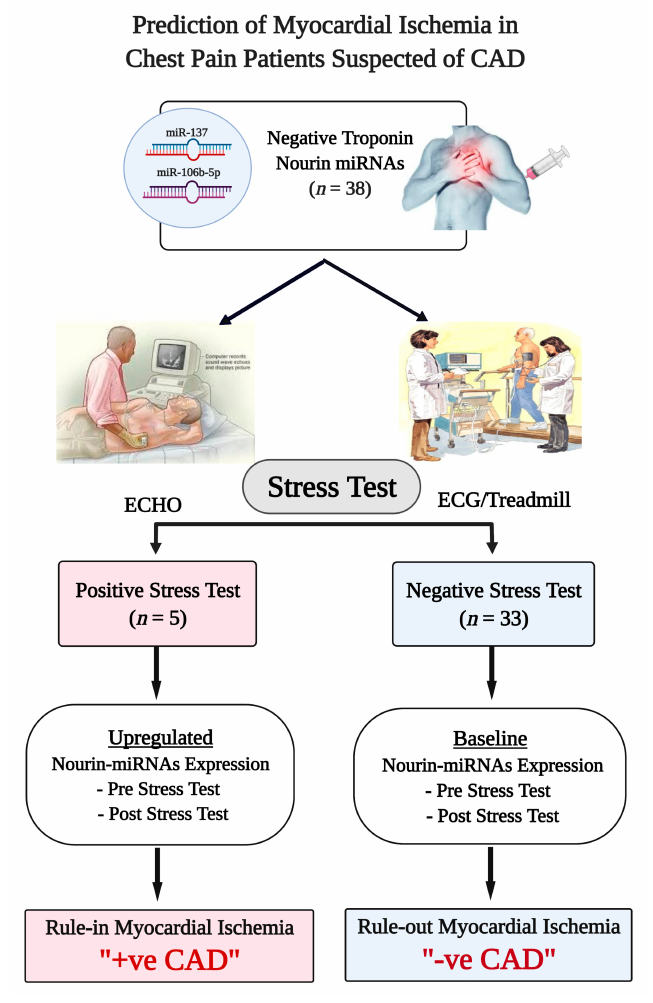
Figure 1. Flowchart Study Design. Abbreviations: CAD: coronary artery disease, ECHO: echocardio- graphy, ECG: